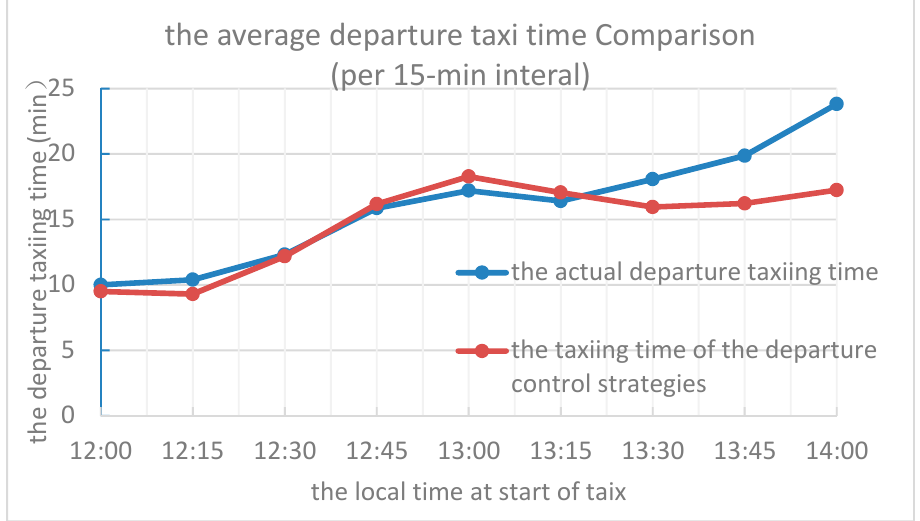
Figure 7. The scatter diagram of the relationship between the flight taxi time and the taxi distance.